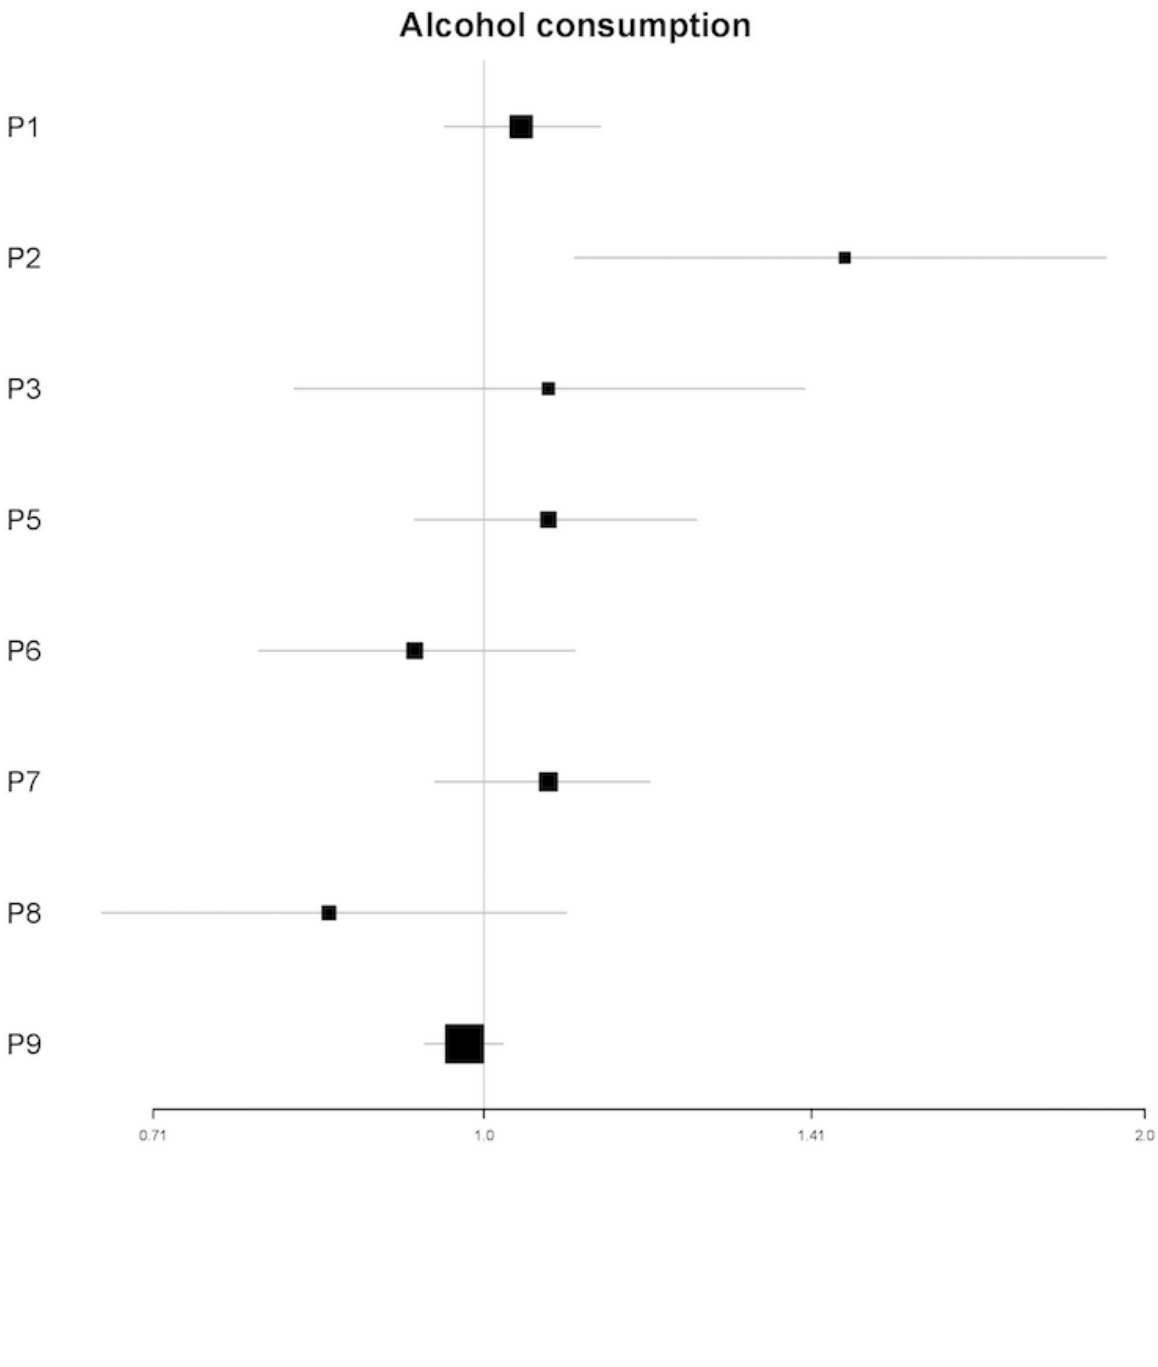
Figure 7. Plot of incidence rate ratios and 95% CIs (x-axis) for the association of alcohol consumption and the frequency of engagement for each participant (y-axis) in univariable analyses. For P4, the univariable model did not converge. P4 is hence not included in this plot. P: